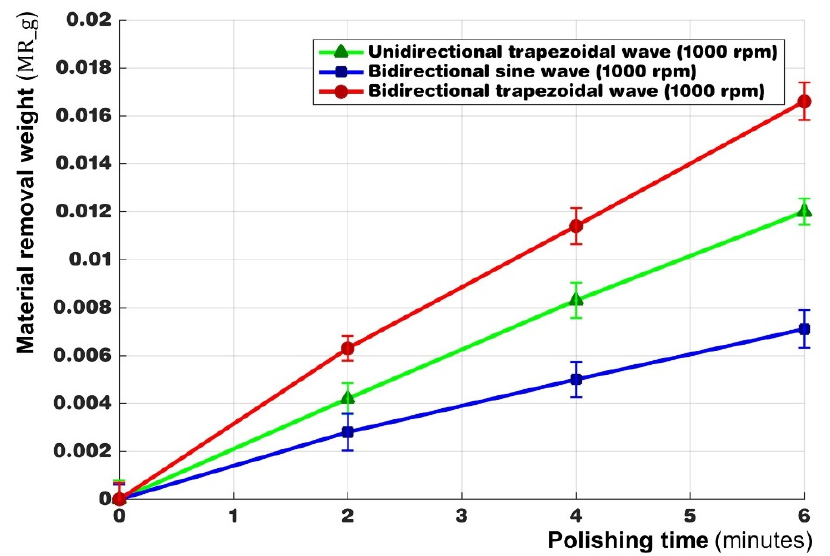
Figure 5. Comparison chart of average surface roughness and polishing time of three motor operat- ing modes.